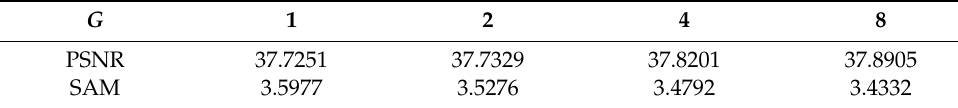
Table 2. Convergence analysis of G when T =